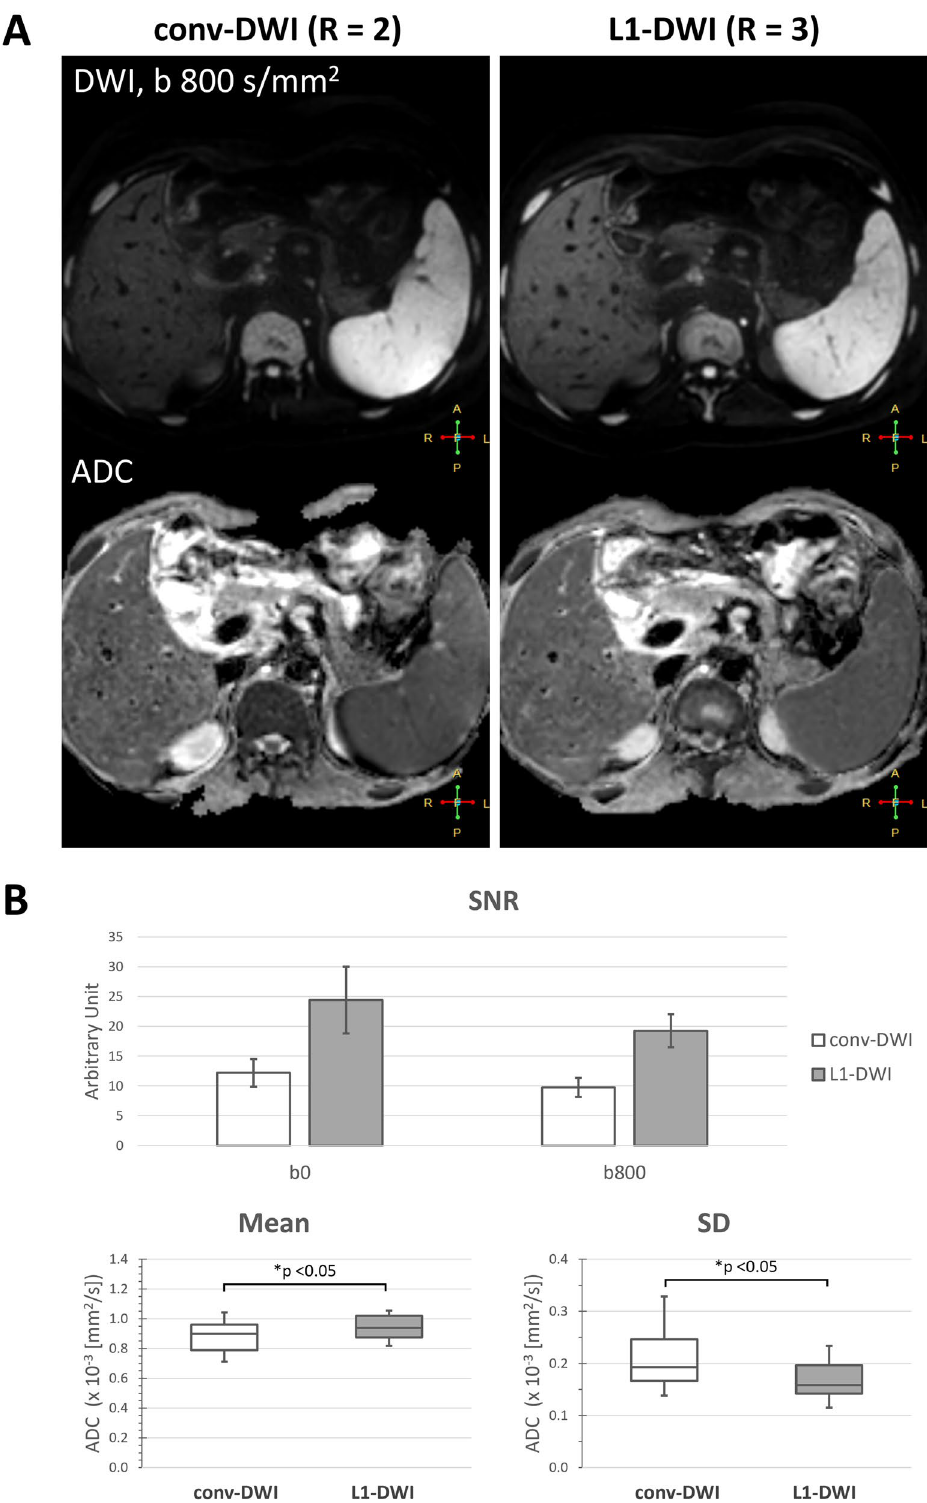
Figure 2. Comparison between liver conv-DWI (left) and L1-DWI (right) in healthy volunteers. conv- DWI = single-shot EPI-based DWI with parallel imaging reconstruction. L1-DWI = single-shot EPI-based DWI with L1-regularized iterative reconstruction. SD = standard deviation. ( A ) Images of a 35-year old volunteer of DWI at b = 800 s/mm 2 , and the resulting ADC image. ( B ) Higher SNR in DWI for both b = 0 and 800 s/mm 2 , as well as less variable ADC values were observed in L1-DWI in comparison to conv-DWI in 12